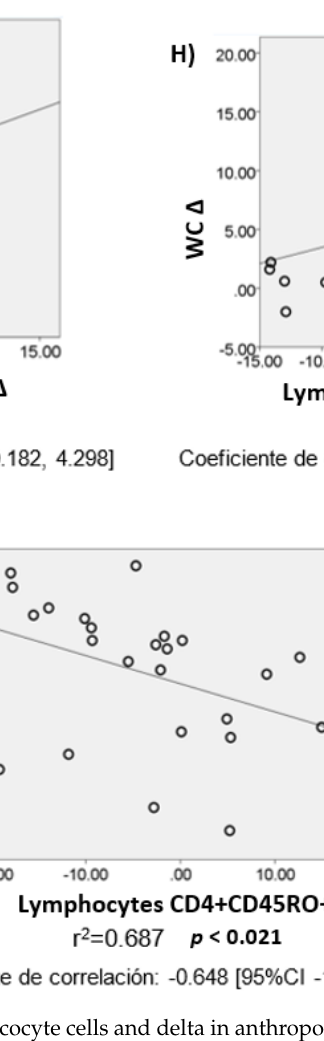
Figure 4. Linear regression between delta in leucocyte cells and delta in anthropometric, biochemical and body composition variables. ( A ) Lineal regression between DBP ∆ vs monocytes ∆ ; ( B ) Lineal regression between ST ∆ vs monocytes ∆ ; ( C ) Lineal regression between TG ∆ vs lymphocytes ∆ ; ( D ) Lineal regression between WC ∆ vs Lymphocytes CD4+CD62- ∆ ; ( E ) Lineal regression between TS ∆ vs Lymphocytes CD8+CD28- ∆ ; ( F ) Lineal regression between TCho ∆ vs Lymphocytes CD4+CD45RA+ ∆ ; ( G ) Lineal regression between c-LDL ∆ vs Lymphocytes CD4+CD45RA+ ∆ ; ( H ) Lineal regression between WC ∆ vs Lymphocytes CD4+CD45RA+ ∆ ; ( I ) Lineal regression between Glu ∆ vs Lymphocytes CD4+CD45RO+ ∆ . DBP: diastolic blood pressure; TG: triglycerides; WC: waist circumference; TCho: total cholesterol; c-LDL: Low-density cholesterol; Glu: glucose; ST: subcutaneous adipose tissue. p value adjusted by sex, age and BMI ( p <